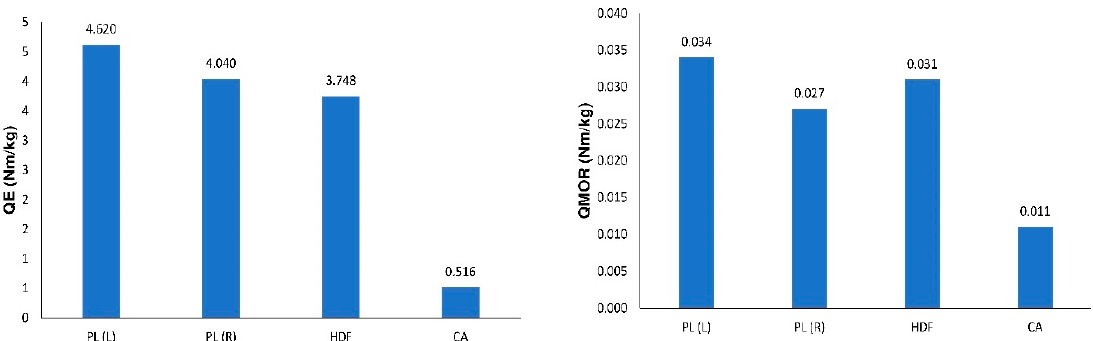
Figure 8. A comparison of Q E and Q MOR for selected wood-based composites.